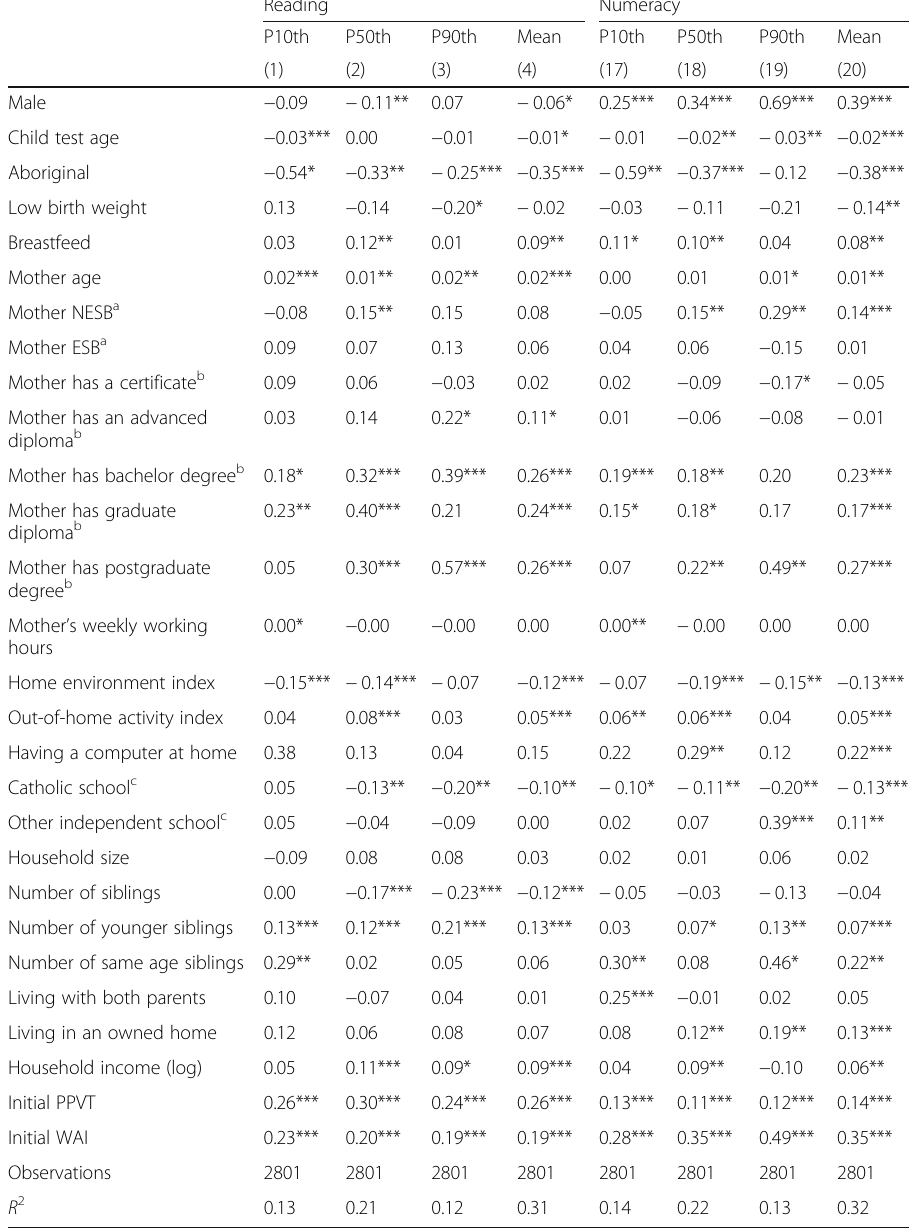
Table 11 Full regression results at selected percentiles and at mean — grade